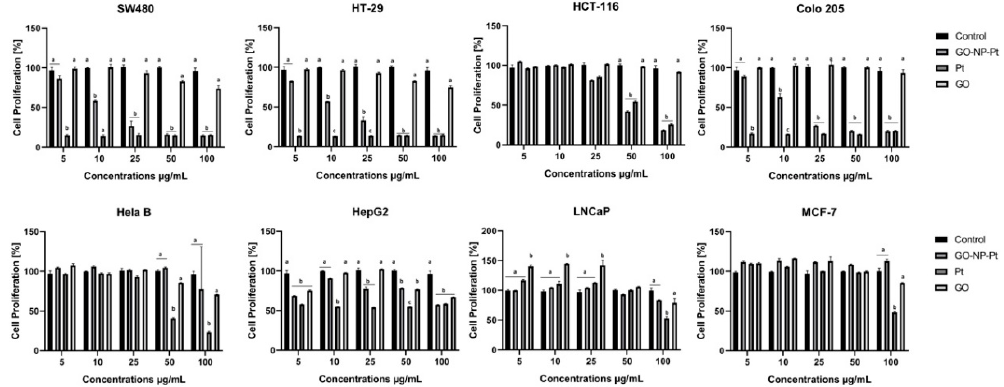
Figure 3. Effects of nanocomplexes of graphene oxide and platinum nanoparticles, platinum nanoparticles, and graphene oxide. on cell proliferation. Notes: Different lowercase letters (a and b) within columns indicate significant differences between the concentrations (P < 0.05). Abbreviations: